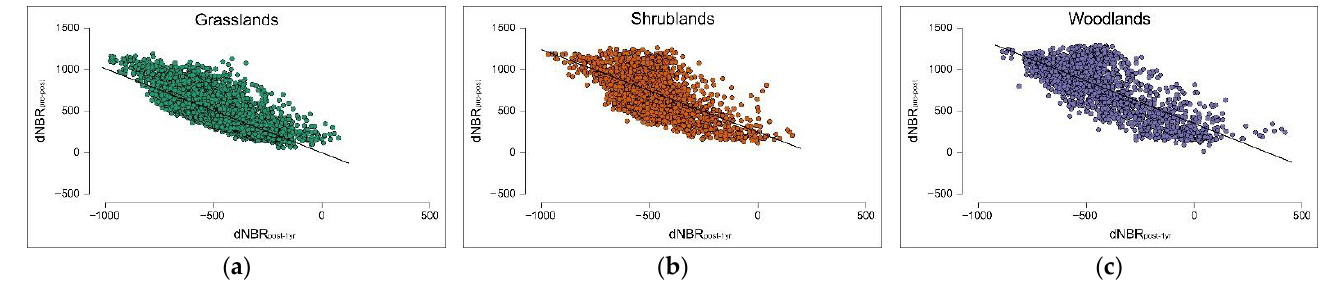
Figure 7. Scatterplots of dNBR pre-post and dNBR post-1yr correlations for ( a ) grasslands, ( b ) shrublands, and ( c ) woodlands.